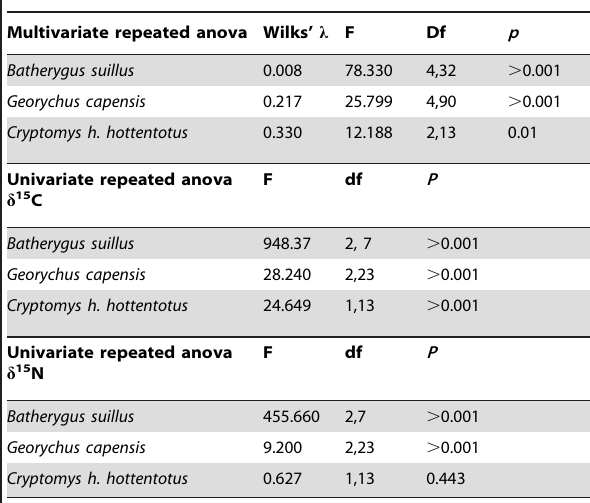
Table 4. ANOVAs show significant differences between the means of the isotopic values of claws in individuals of B. suillus , with most of the variance explained by between individual rather than within individual differences.